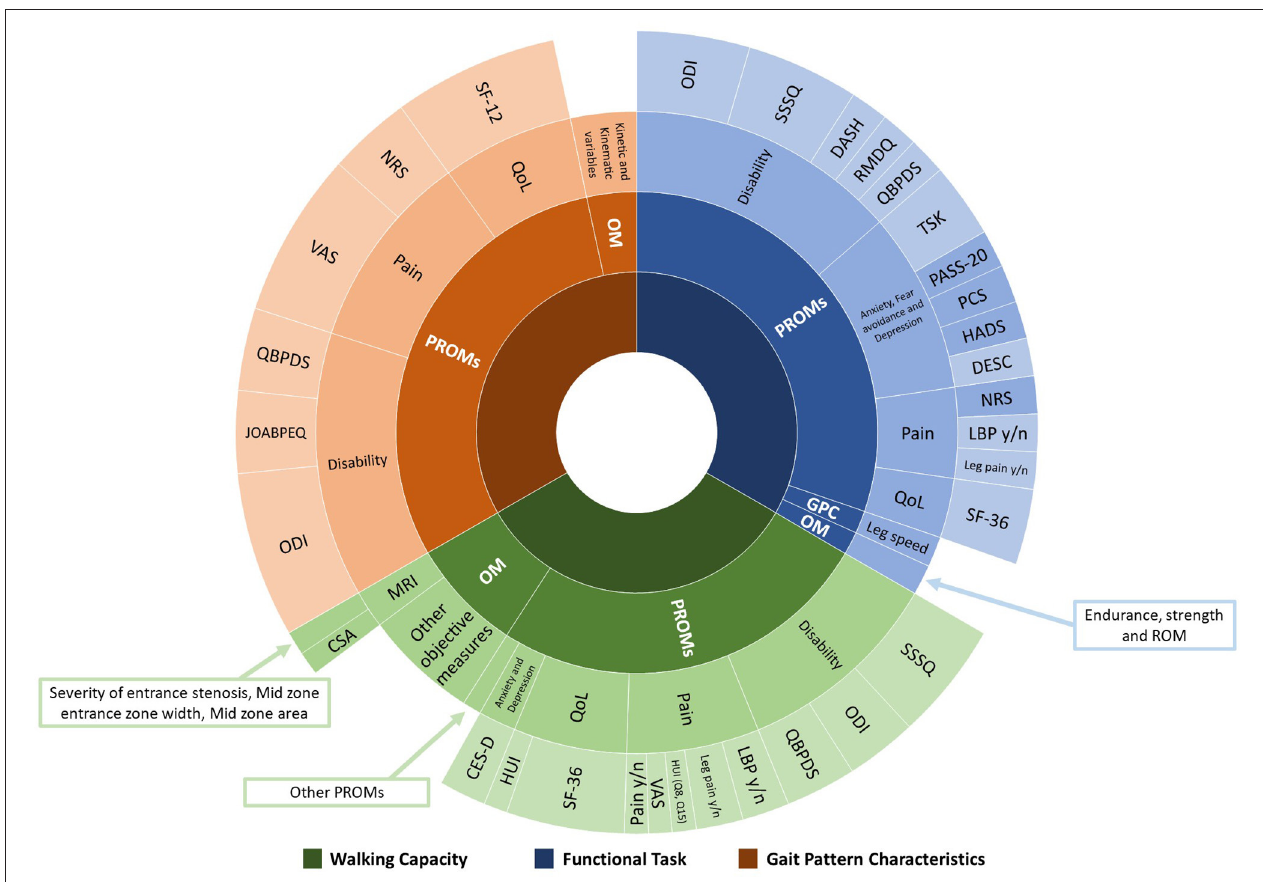
FIGURE 2 | Range and proportion of tools used to assess physical and psychological factors associated with walking capacity, functional task, and gait pattern characteristics. PROMs, Patient-Reported Outcome Measures; OM, Objective Measures; GPC, Gait Pattern Characteristics; QoL, Quality of Life; MRI, Magnetic Resonance Imaging; ODI, Oswestry Disability Index; SSSQ, Swiss Spinal Stenosis Questionnaire; DASH, Disability of the Arm, Shoulder and Hand questionnaire; RMDQ, Roland-Morris Disability Questionnaire; QBPDS, Quebec Back Pain Disability Scale; TSK, Tampa Scale of Kinesiophobia; PASS-20, Pain Anxiety Symptoms Scale; PCS, Pain Catastrophizing Scale; HADS, Hospital Anxiety and Depression Scale; DESC, Rasch-based Depression Screener; NRS, Numeric Rating Scale; LBP, Low Back Pain; SF-36, 36-item Short Form Health Survey; SF-12, Medical Outcomes Short-Form 12; HUI, Health Utilities Index Mark 3; VAS, Visual Analog